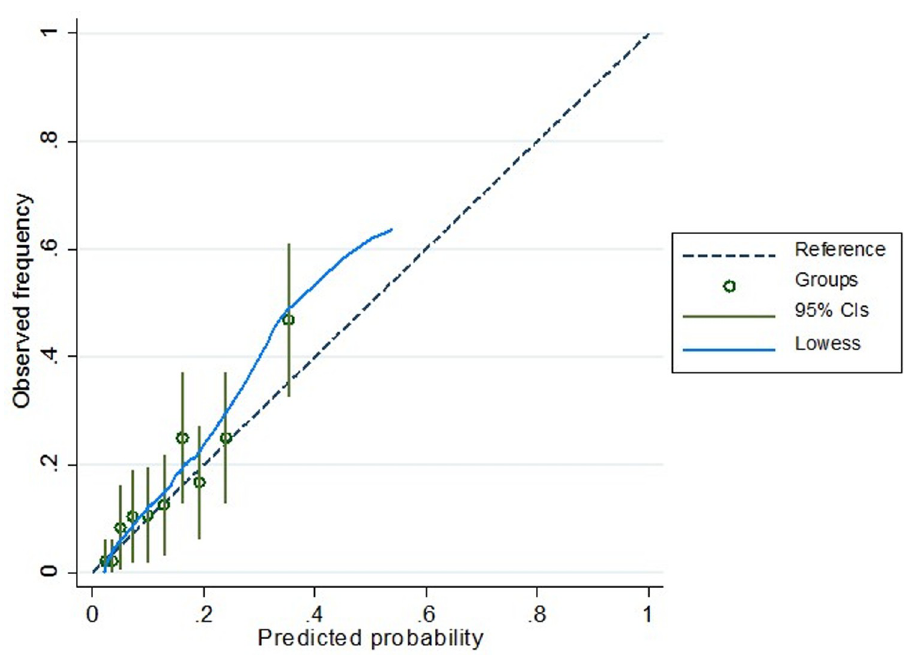
Fig 3. Calibration curve from multiple logistic regression: Emergency CS.